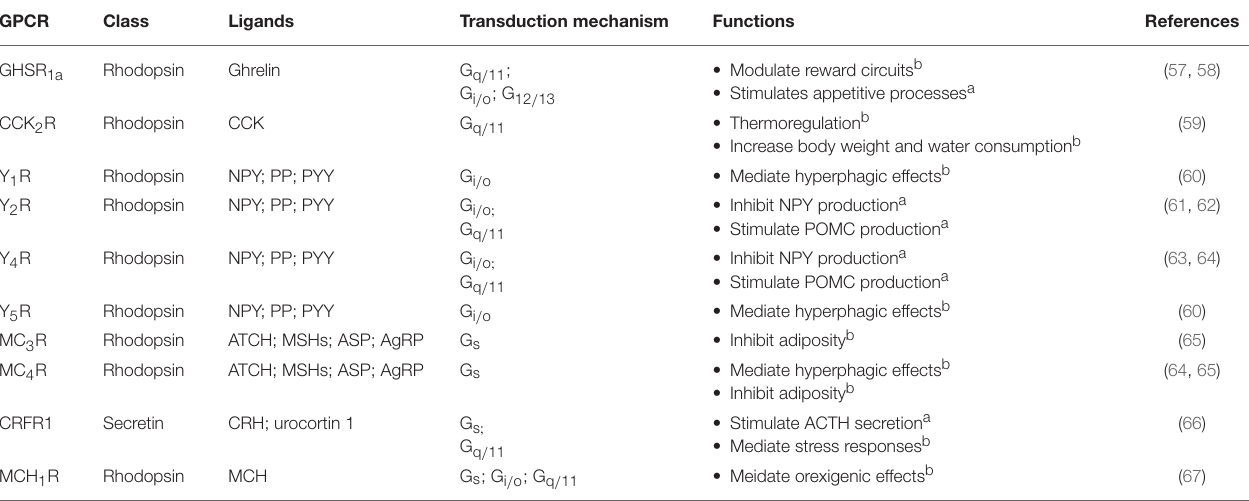
TABLE 3 | Examples of GPCRs for regulating neuoendocrine functions in